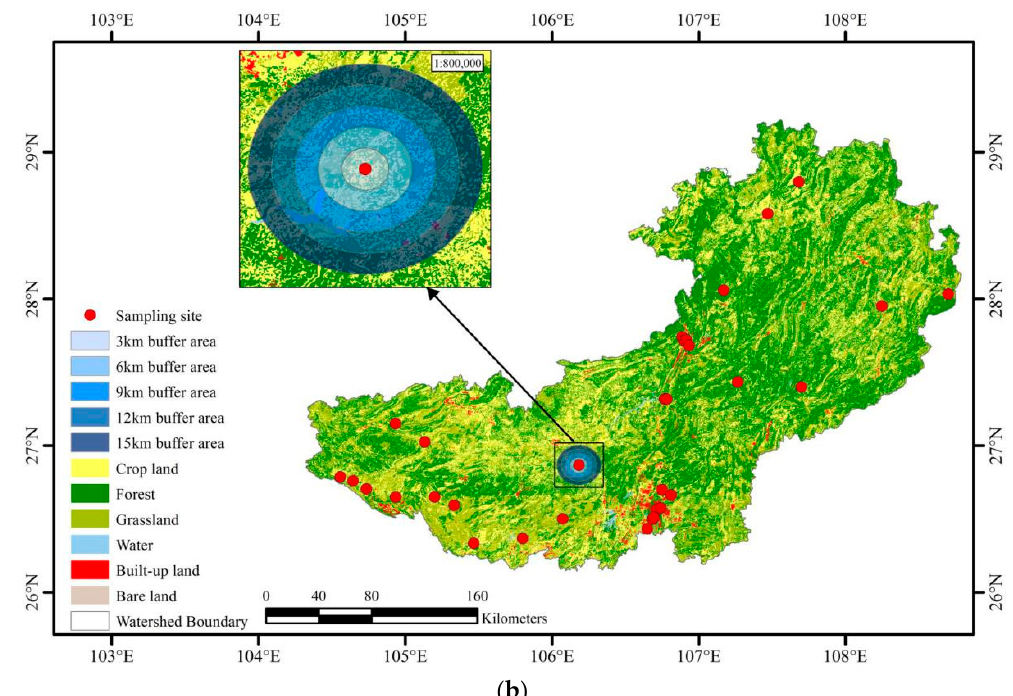
Figure 1. Wujiang river watershed displaying ( a ) a digital elevation model and ( b ) land use pattern.